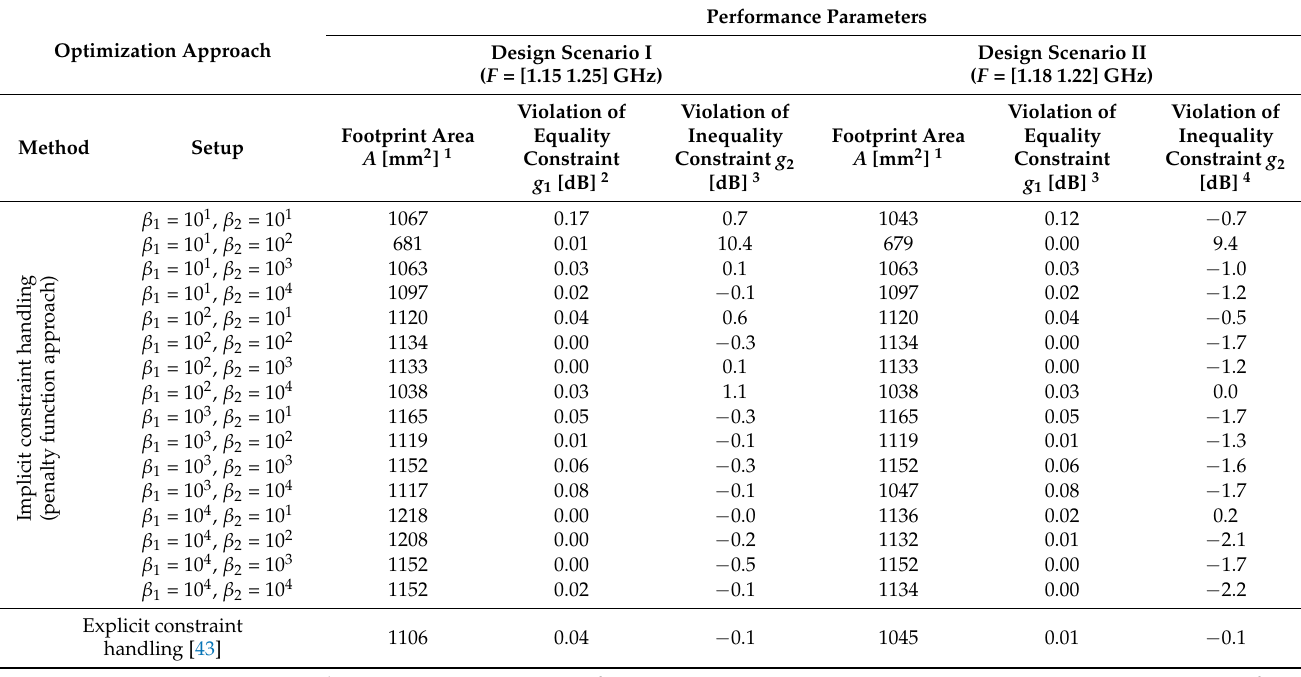
Table 4. Optimization results for the circuit of Figure 13.